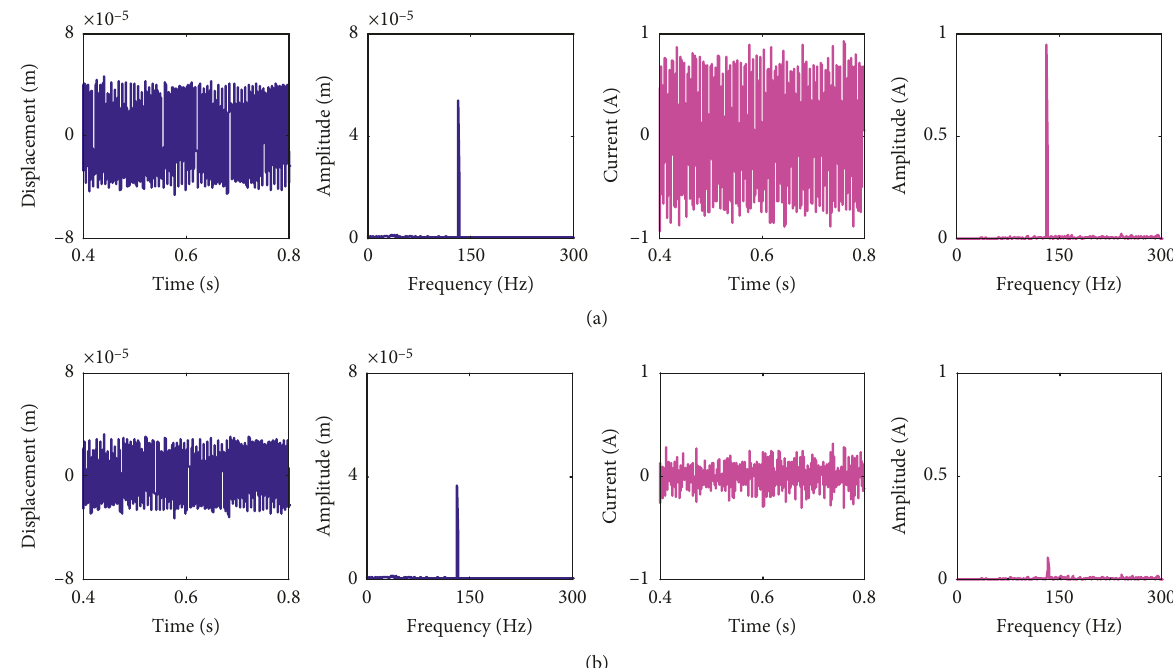
Figure 9: Comparison of vibration response at 8000rpm (a) without unbalance control and (b) with unbalance